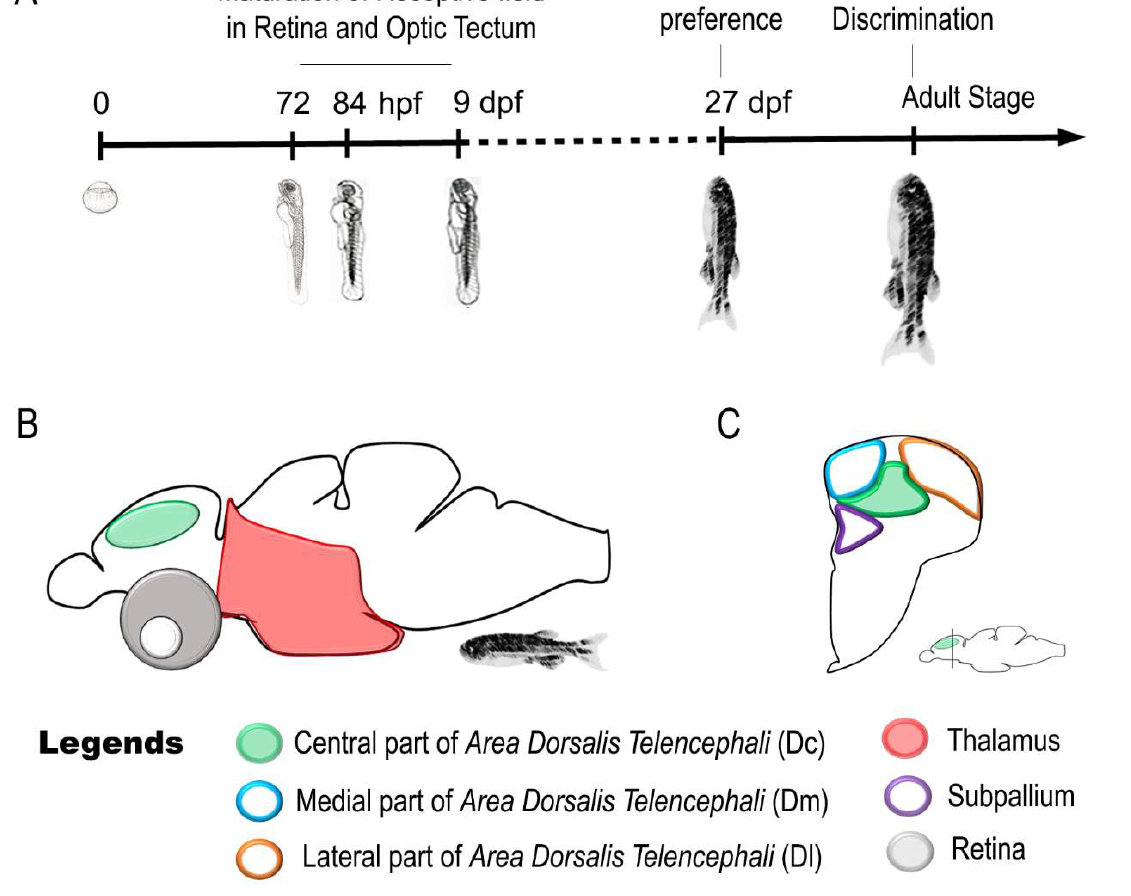
Figure 2. Neural correlates of numerosity cognition in zebrafish. ( A ) Possible timeline of development of number sense in zebrafish. ( B ) Schematic representation of telencephalic and thalamic nuclei activated upon a change in visual numerosity in zebrafish adult brain. ( C ) Molecular biology analyses revealed that the caudal region of central part of the area dorsalis telencephali (Dc) responds to change in numerosity of visual stimuli in adult zebrafish brain.